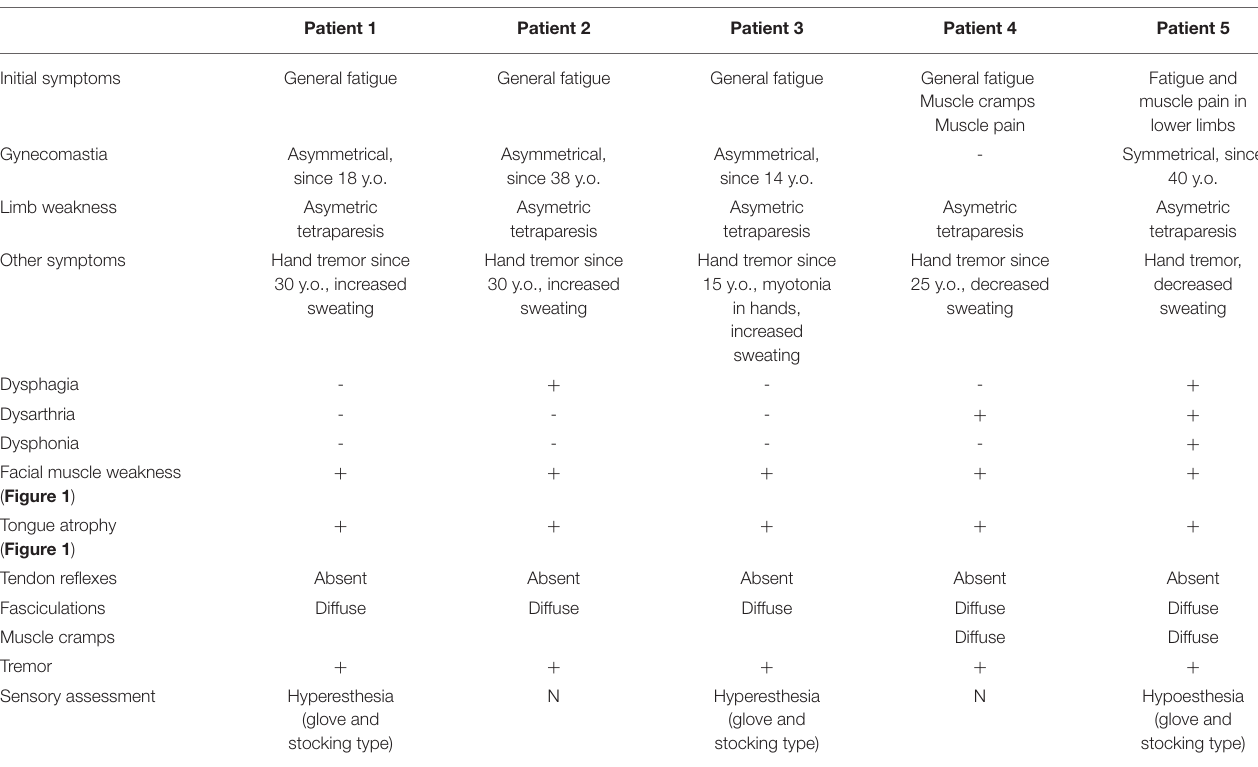
TABLE 2 | Clinical